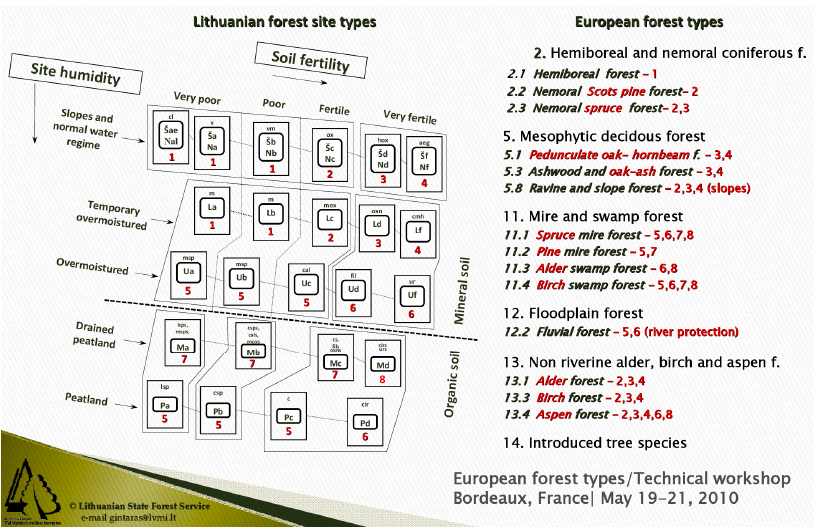
Figure 1. The relationship between Lithuanian forest site types and European forest types [109,111,116,117].